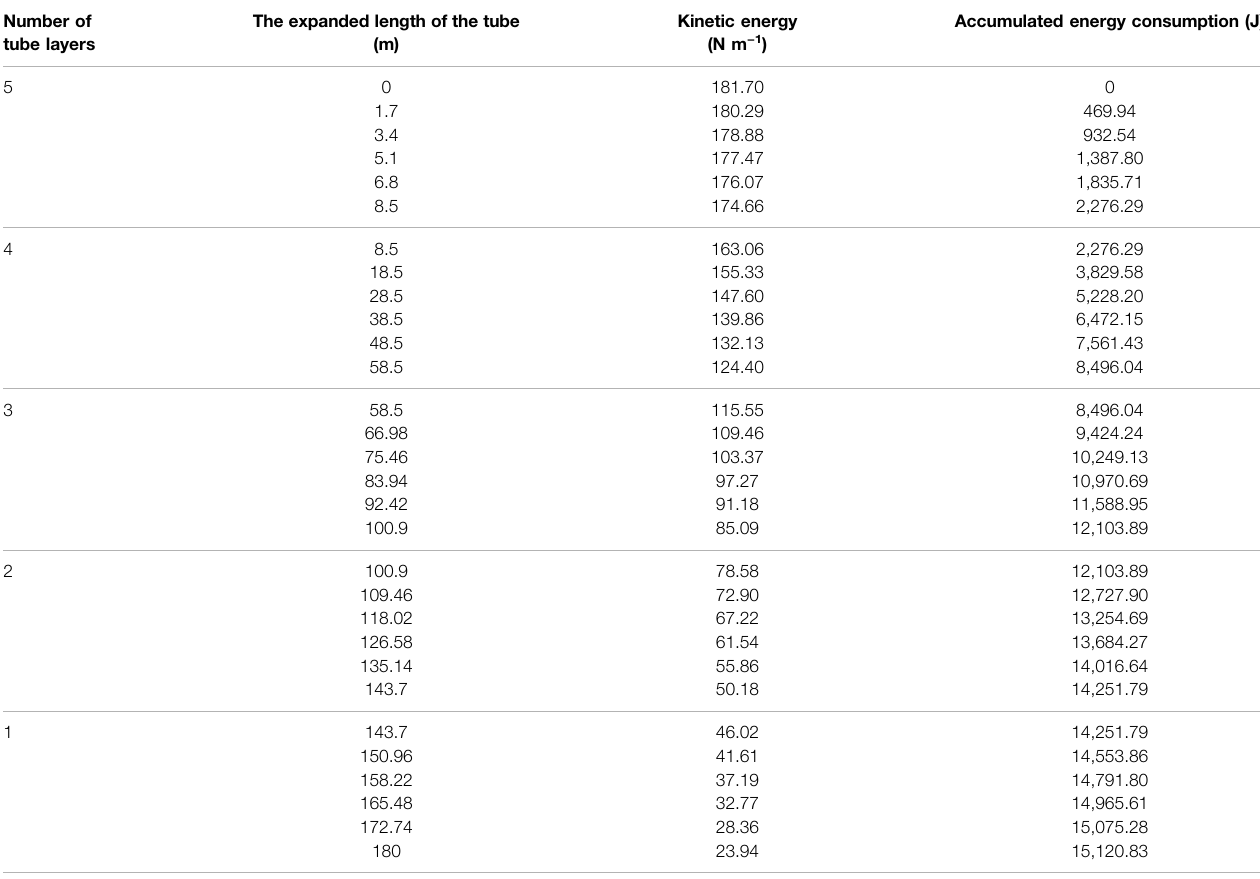
TABLE 3 | Change parameters of reel energy consumption.